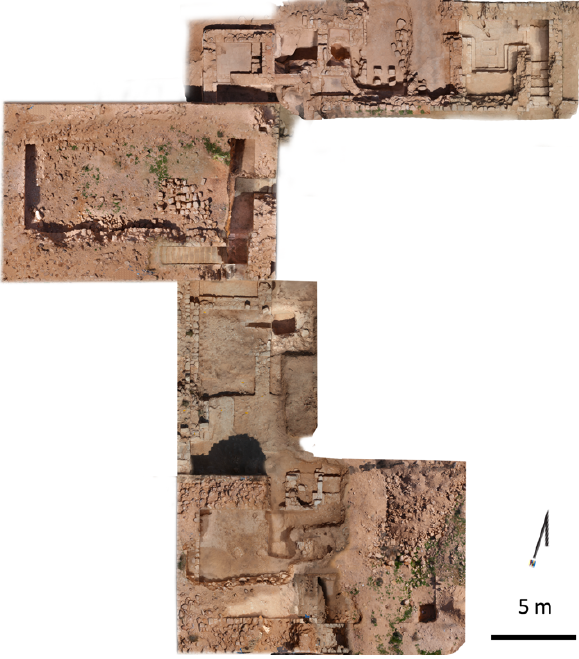
Figure 7: Ortho-Photo of the site from years 2015 to